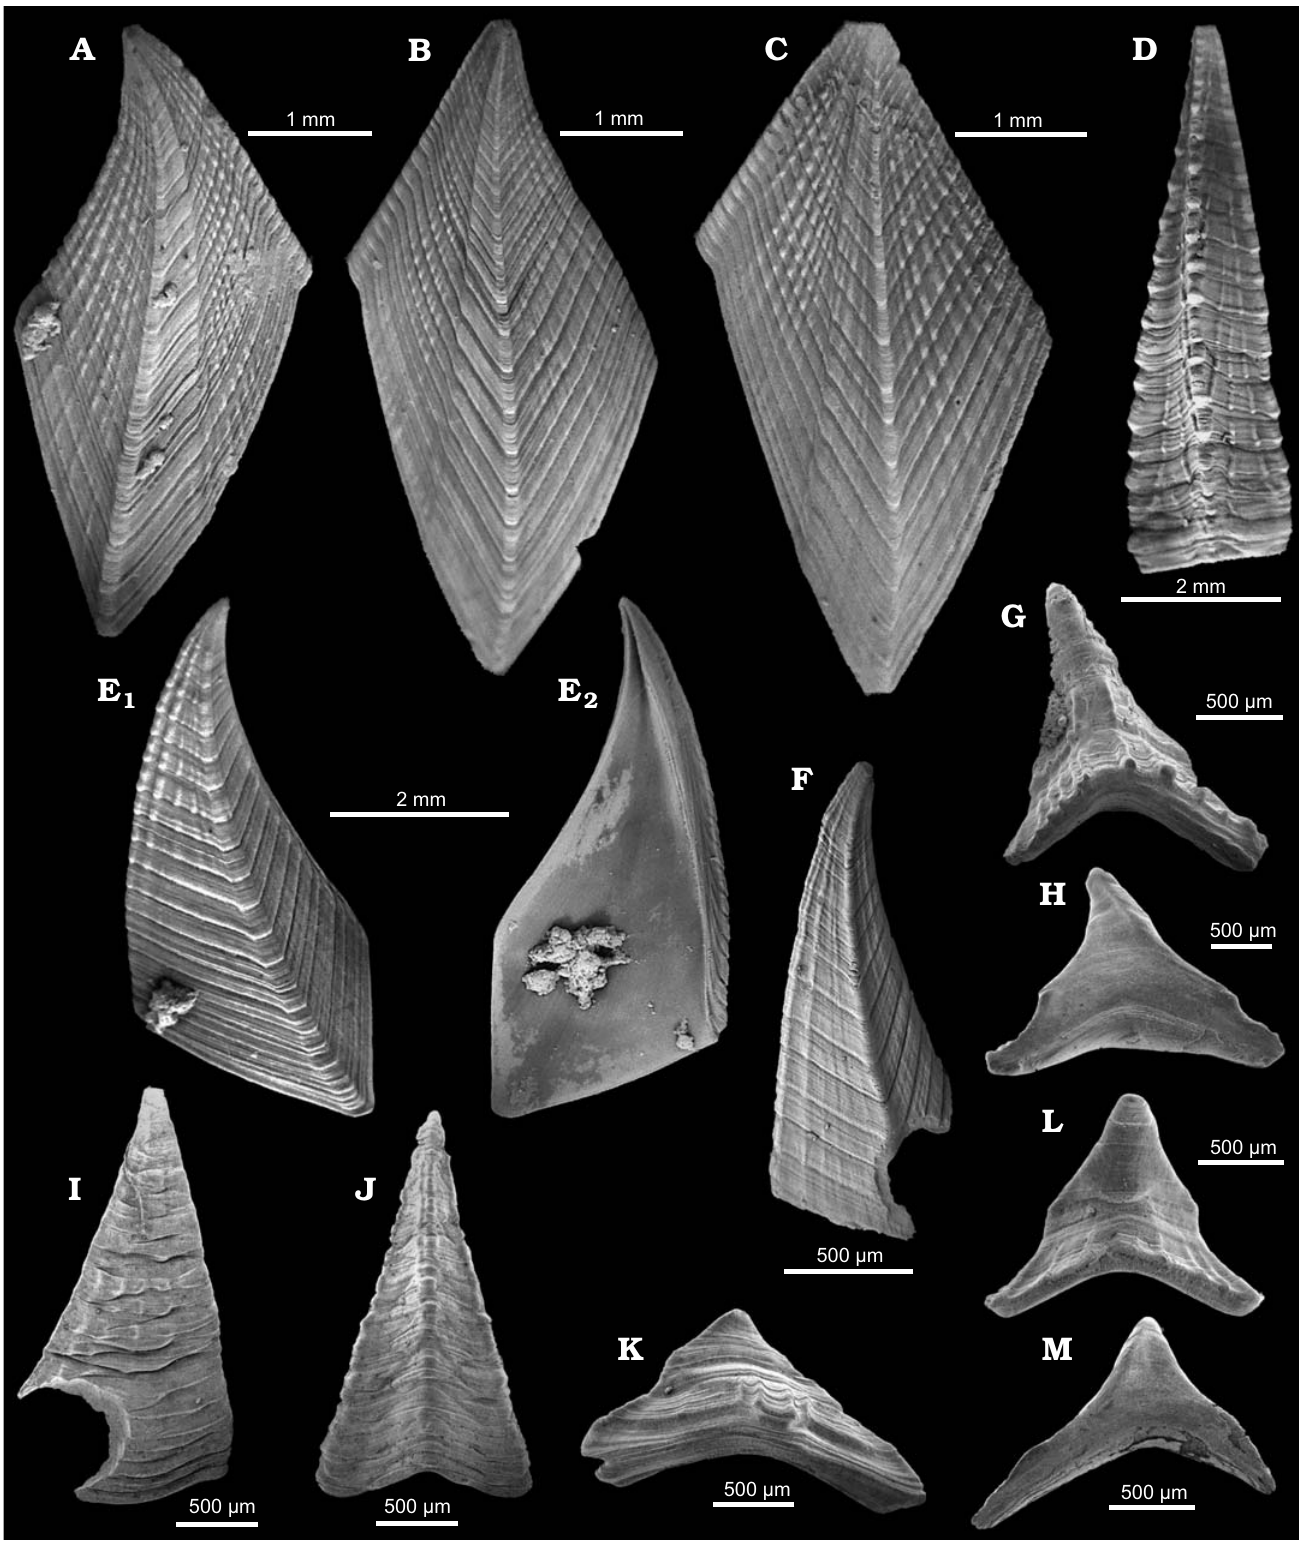
Fig. 4. Plates of neolepadid cirripede Ashinkailepas indica Gale sp. nov. from Late Pleistocene, 52.6 ka) Krishna-Godavari Basin, offshore